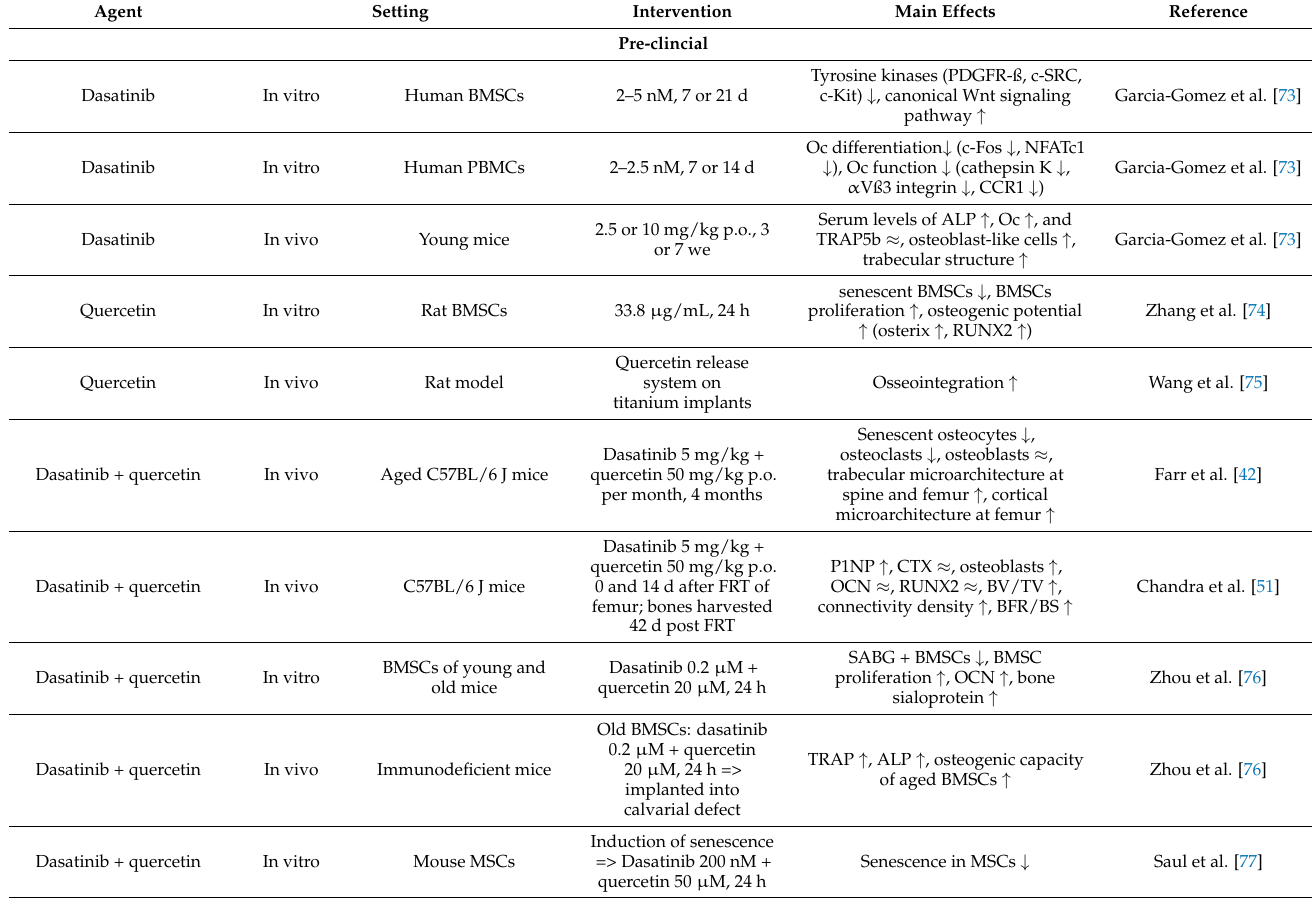
Table 1. Selected pre-clinical and clinical studies on bone effects of